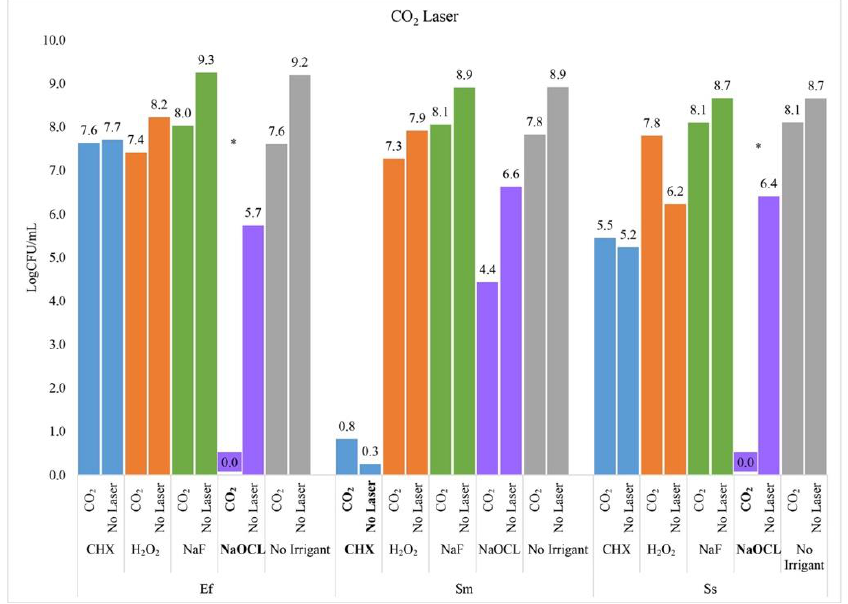
Figure 1. CO 2 Laser. Asterisk indicates a statistically significant difference between the two groups Int. J. Mol. Sci. 2022 , 23 , x FOR PEER REVIEW (i.e. Laser+Irrigant vs Irrigant Alone) based on Tukey’s adjusted pairwise comparisons. (i.e., Laser + Irrigant vs. Irrigant Alone) based on Tukey’s adjusted pairwise comparisons.